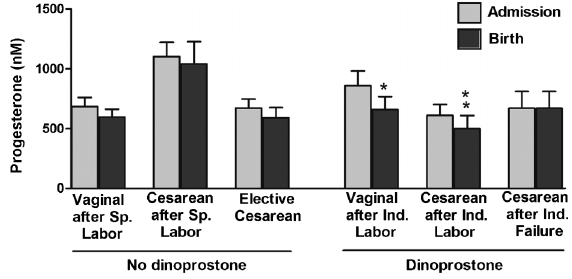
Figure 1. Maternal serum levels of progesterone at admission and immediately before birth in patients with and without dinoprostone treatment. Sp. = spontaneous; Ind. = induced or induction. *P , 0.005 and **P , 0.025 compared to the respective admission mean for patients with and without dinoprostone treatment (two-way ANOVA followed by the F-test for simple